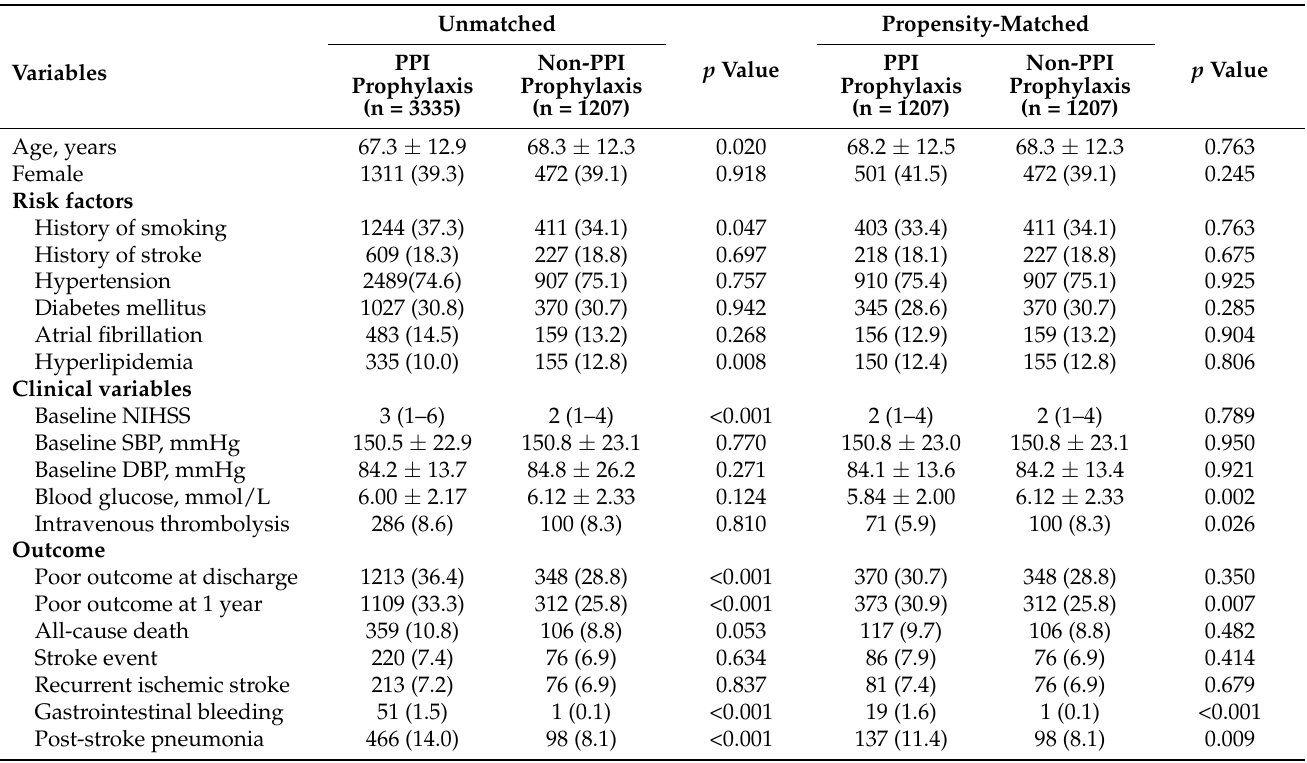
Table 1. Demographic and clinical characteristics of the study population.